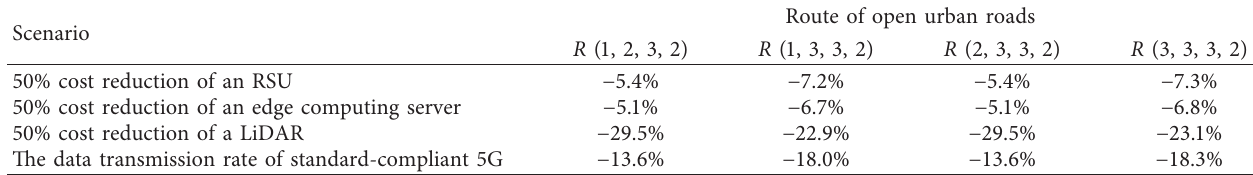
Table 6: Scenario analysis: impact of key elements on the total upgrade cost per kilometer on open city roads.